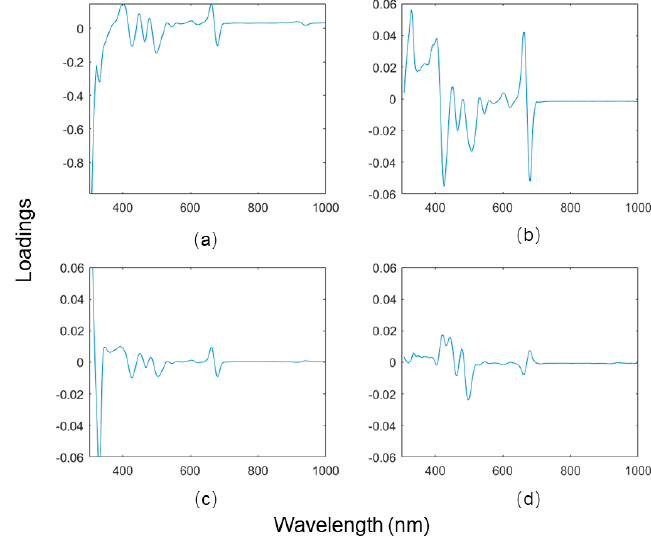
Figure 4. Principal component loadings plot of the first four principal components (PC1-PC4), ( a ) PC1; ( b ) PC2; ( c ) PC3; ( d ) PC4.